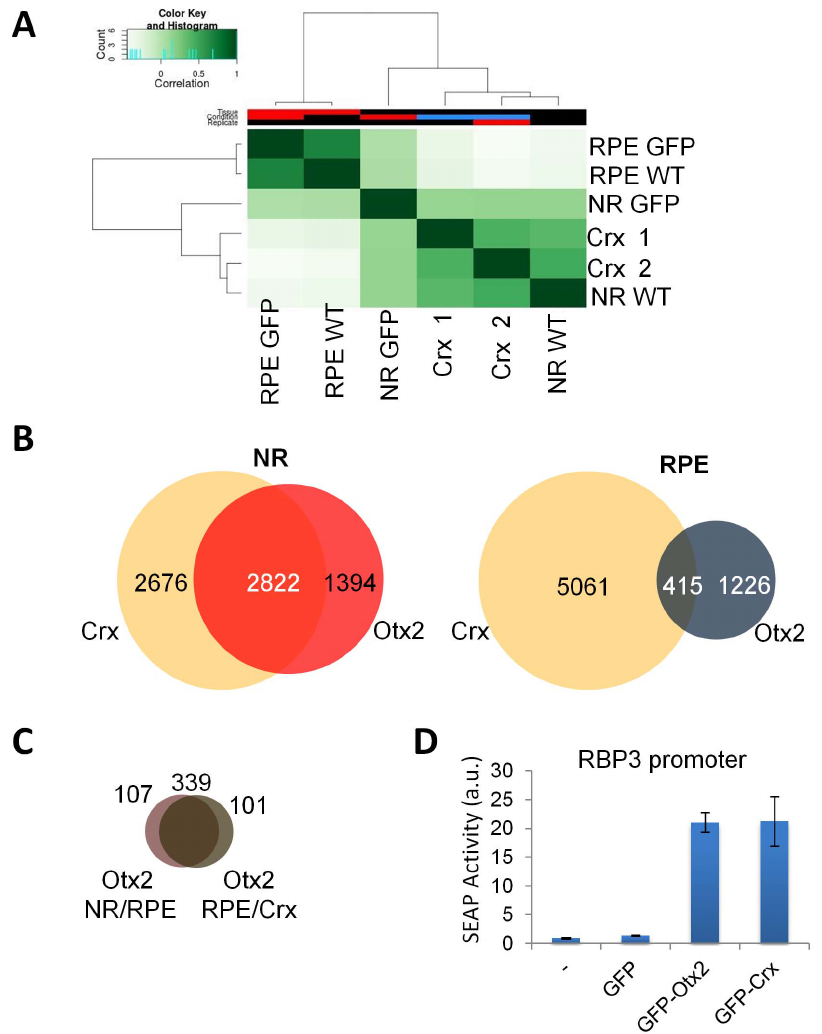
Figure 5. Otx2 and Crx redundancy in the neuroretina. A. Heatmap and dendrogram representation of Diffbind clustering of the indicated ChIP-seq experiments. B. Venn diagrams showing overlapping Crx bound regions (CBRs) and OBRs in the NR and in the RPE. CBRs represented the intersection of both Crx ChIP-seq replicates. C. Venn diagram showing the overlap between the above 415 common OBRs/CBRs in the RPE (grey) and the 426 OBRs common to RPE and NR (purple) shown in Fig. 4A. D. Otx2 and Crx transactivation of the RBP3 promoter.